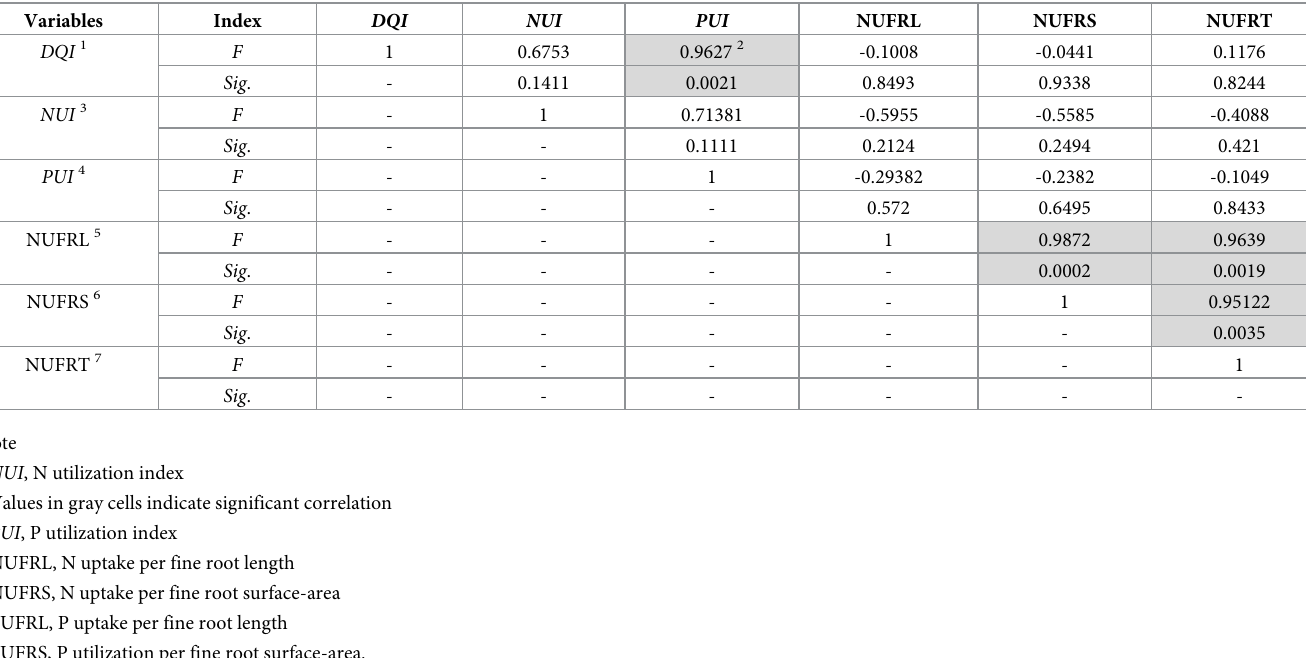
Table 6. Pearson correlation among pairs of uptakes and utilizations in nitrogen (N) and phosphorus (P) nutrients in Podocarpus macrophyllus